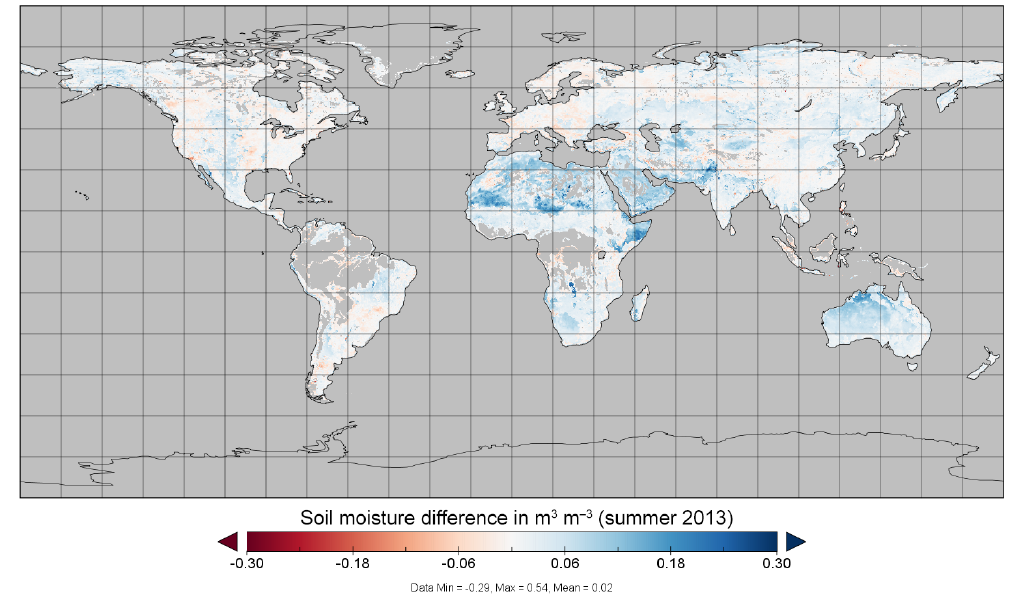
Figure B4. Absolute differences in soil moisture (ESA CCI SM minus CCI NRT) for summer 2013.